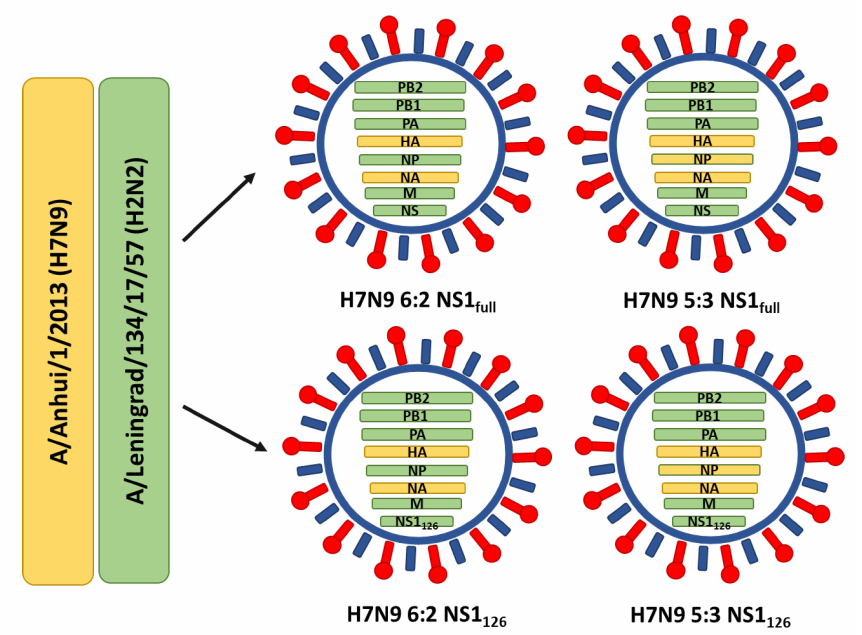
Figure 1. Overview of the LAIV reassortant viruses used in this study and their genome compositions. A 7:1 PR8-based reassortant influenza virus bearing NP gene of the A/Anhui/1/2013 (H7N9) virus was additionally generated for this study to assess the protective potential of the NP-specific T cells. The PR8/H7N9 7:1 virus was rescued in Vero cells and amplified in eggs as described above. The identity of the genomes of all rescued influenza viruses was confirmed by full-genome Sanger sequencing using BigDye Terminator v3.1 Cycle Sequencing Kit (Thermo Scientific,